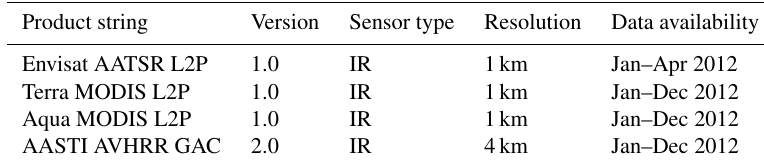
Table 1. Input satellite data used for the derivation of the daily L4 IST product.